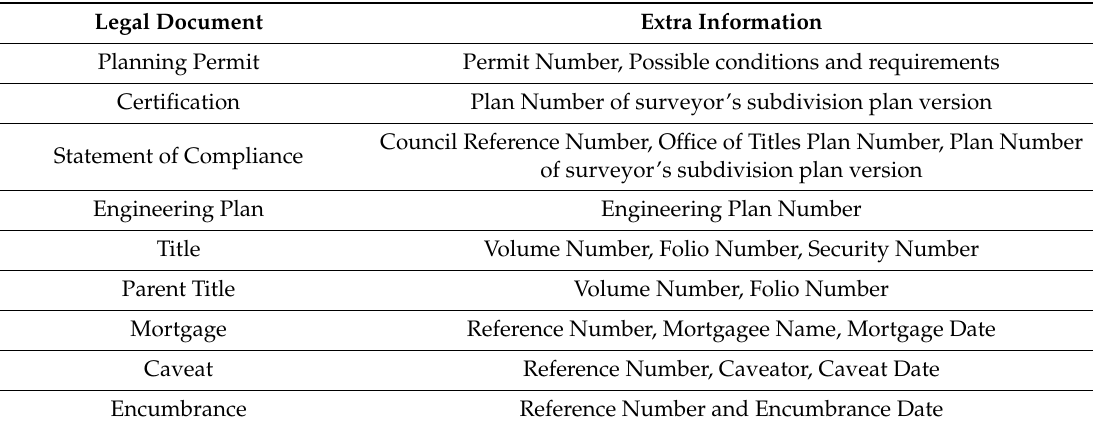
Table 2. Extra attributes relating to legal documents to be included in Description attribute of the “IfcDocumentInformation”